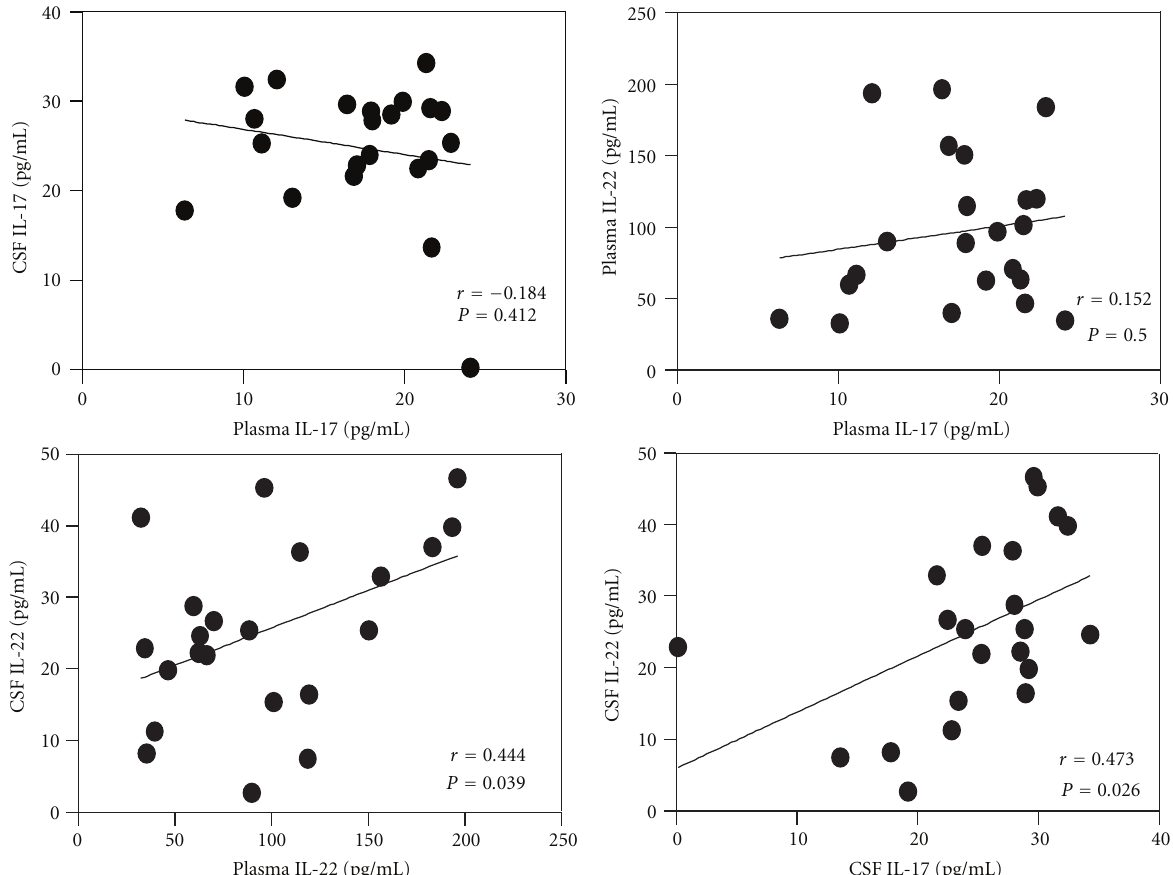
Figure 3: The correlations of CSF and plasma levels of IL-17 and IL-22. The Pearson correlation coe ffi cient was used to analyze between two sets. Each circle = single individual; lines = linear